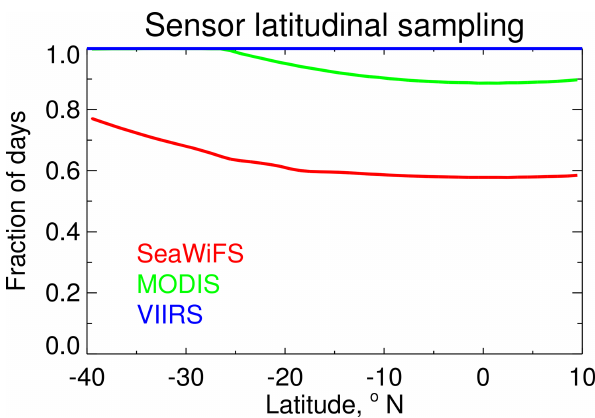
Figure 3. Fraction of days a given point (longitude) in the retrieval domain (Fig. 2) is observed at least once by the individual SeaWiFS, MODIS, and VIIRS sensors, as a function of